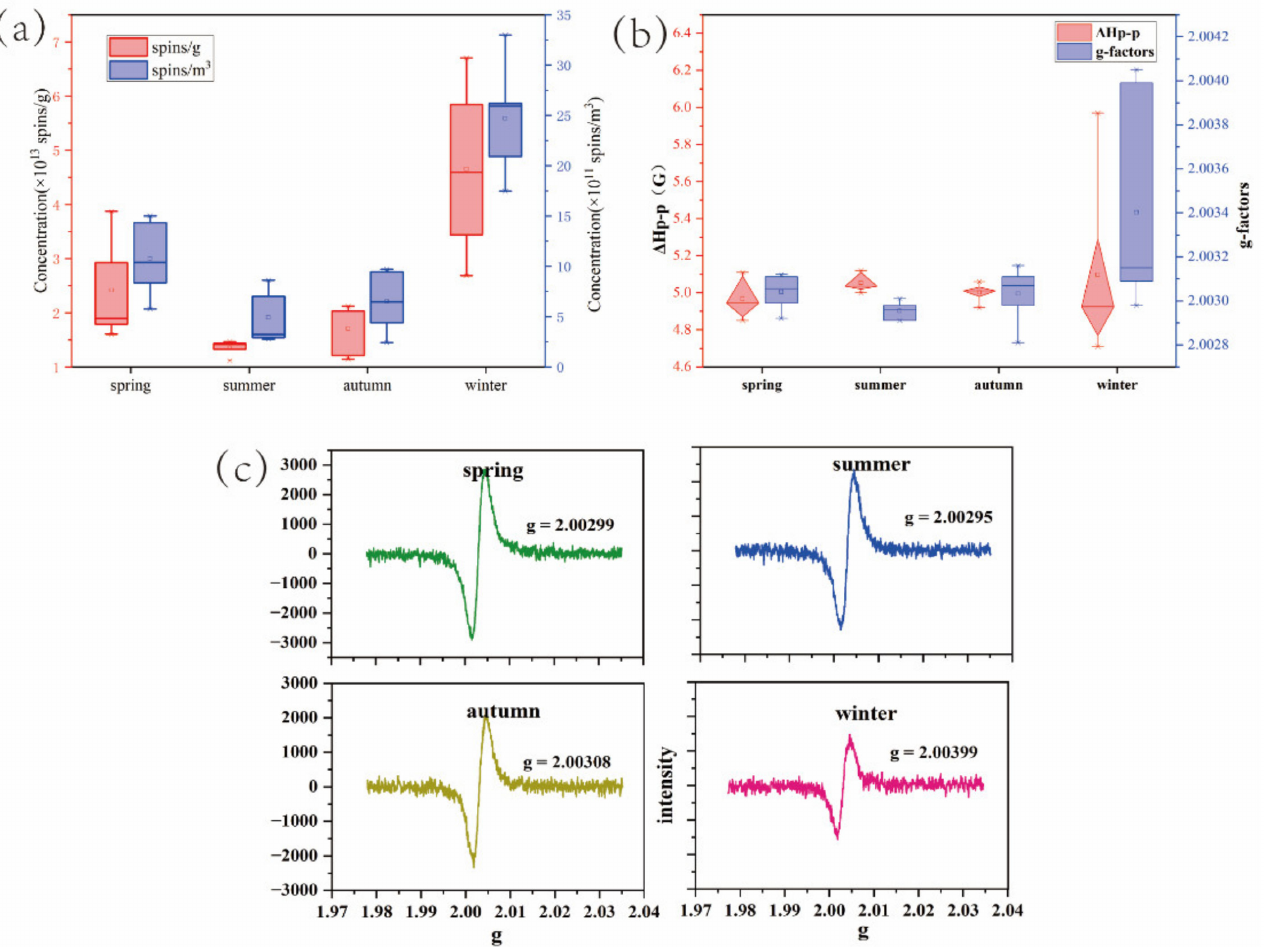
Figure 1. Seasonal distribution trends for EPFR concentrations ( a ), g-factors and ∆ Hp-p values ( b ), and the EPR spectra ( c ) in PM 2.5 in Shihezi between October of 2020 and September of